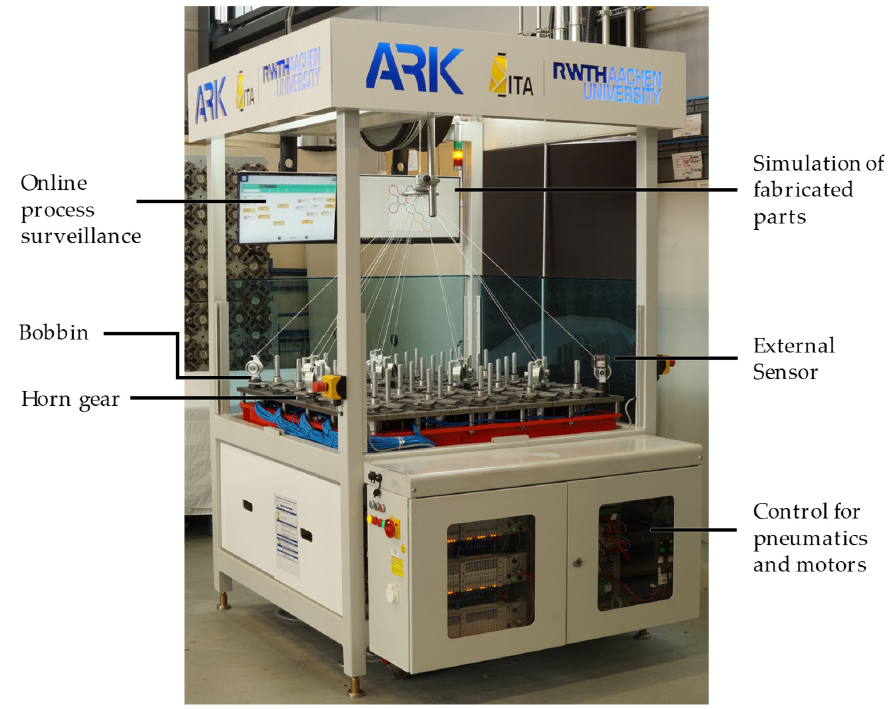
Figure 5. Illustration of the rotary 3D braiding machine at Institut für Textiltechnik (ITA) of RWTH Aachen University, Germany. Adapted from [18].